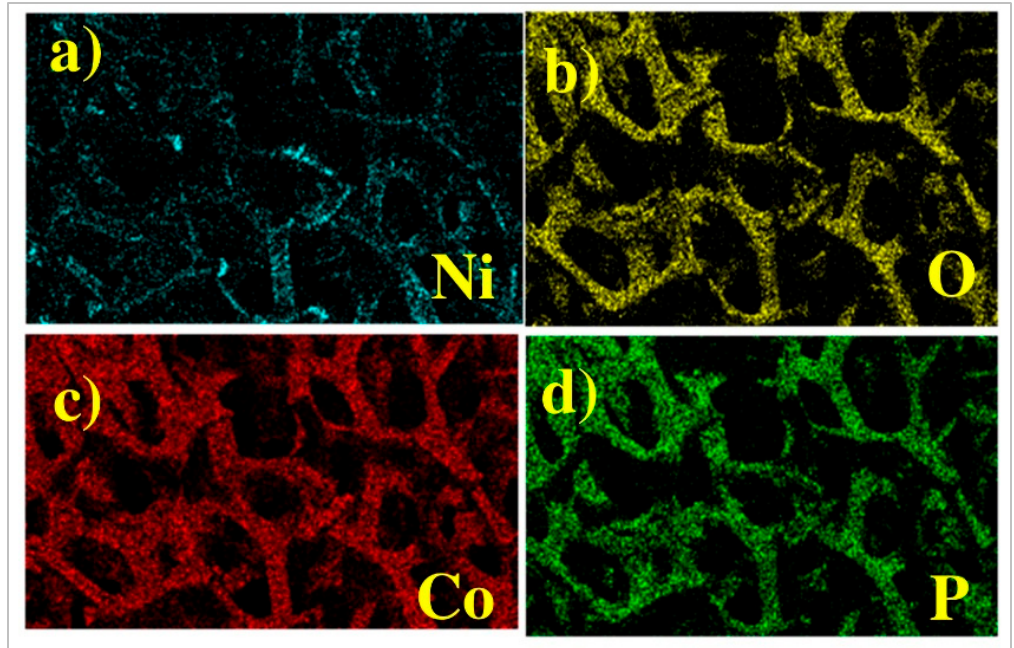
Figure 2. ( a – d ) the element mapping of Ni, O, Co, and P, respectively. The surface chemical state of CoP@NiF is investigated using XPS. The survey spectra of CoP@NiF (Figure 3a) show that Co, P, Ni, and O elements coexist in the electrocatalyst. This was completely consistent with the EDX results. The binding energies (BEs) 781.10 (2p 3/2 ) and 795.59 (2p 5/2 ) eV are ascribed to the binding energies Co 2p 3/2 and Co 2p 1/2 [30]. Satellite peaks are the two remaining deconvoluted peaks, found at 786.54 eV and